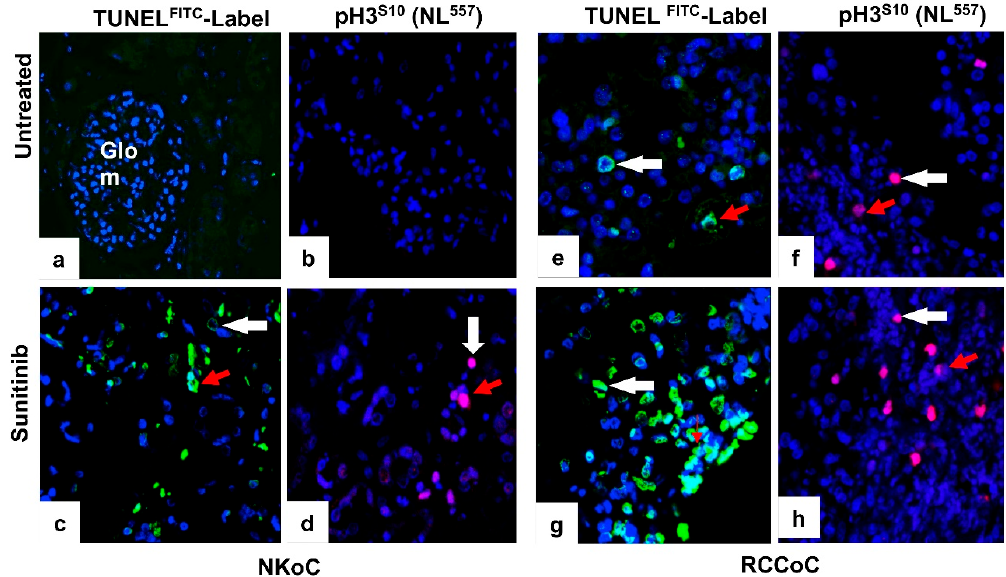
Figure 4. Representative confocal images of TUNEL and pH3 S10 immunostaining on sections of ccRCC and NK organ cultures either untreated or treated with 200µM sunitinib for 1 h at 37 °C. Untreated (UT) controls of NK (panels a , b ) and ccRCC ( e , f ) organ cultures showed negligible signals for TUNEL or pH3 S10 . In contrast, sunitinib treatment resulted in an increased signal for TUNEL signal in NK organ cultures ( c ), more pronounced in ccRCC ( g ). In comparison, sunitinib treatment induced a minimal signal for pH3 S10 in both organ cultures ( d , h ). Tumour cells ( white arrows ), vascular endothelial cells ( red arrows ). N = 3 per group with similar results. Original magnification ×40.